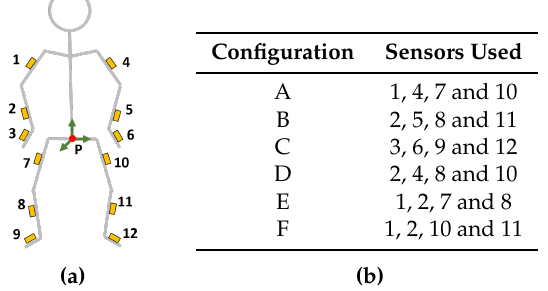
Figure 3. The different sensor configurations that have been investigated, each configuration is denoted by a letter (A–F) and the sensors for each of these configurations are numbered (1–12). ( a ) Sensor locations; ( b ) Sensors in the different configurations. In all configurations, the pelvis (P) is used as a reference